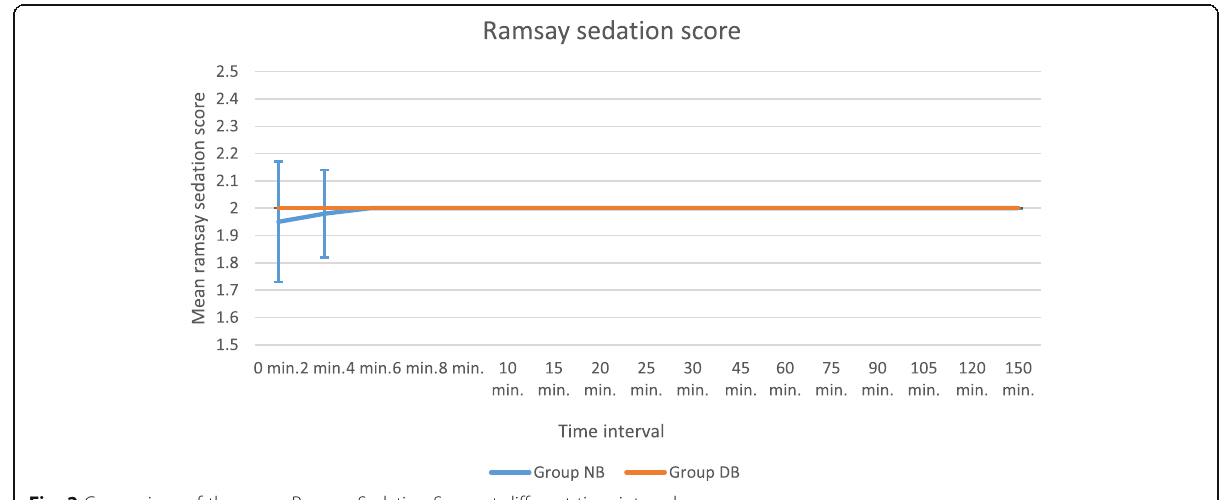
Fig. 2 Comparison of the mean Ramsay Sedation Score at different time intervals